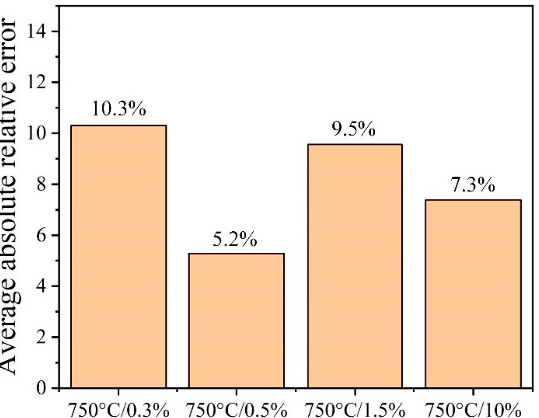
Figure 11. Correlation between the experimental and predicted stress at 750 °C.